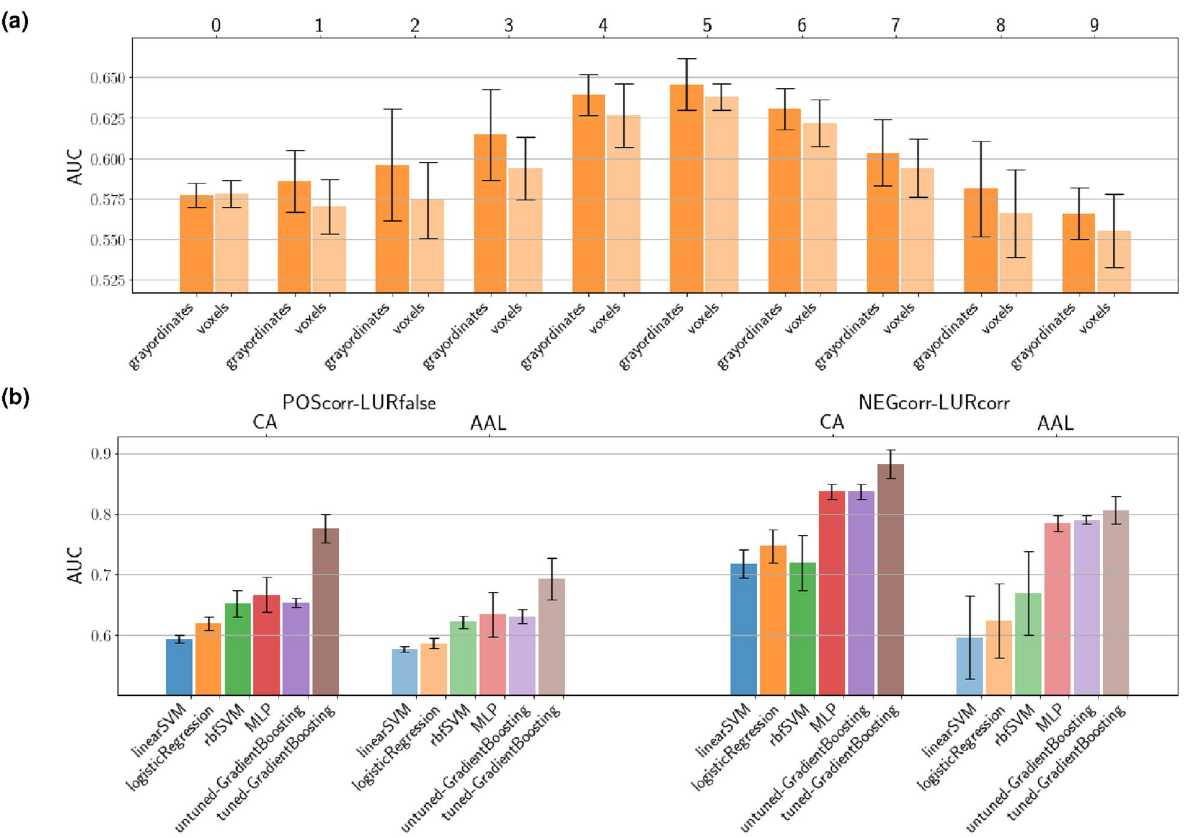
Figure 1. The mean of AUC for 5-fold cross-validation of different classification methods. ( a ) Results of logistic regression classifier for POScorr–LURfalse at time 0–9 TR (upper horizontal axis) post retrieval event for both surface and volumetric data (bottom horizontal axis). All data was normalized to have zero mean and unit standard deviation. ( b ) Results for two type of data: Cole–Anticevic (CA) and Automated Anatomical Labelling (AAL). We consider two classification problems POScorr–LURfalse , NEGcorr–LURcorr and five classifiers: logistic regression , linear SVM , rbf SVM , MLP (deep classifier), and the gradient boosting of decision trees 21